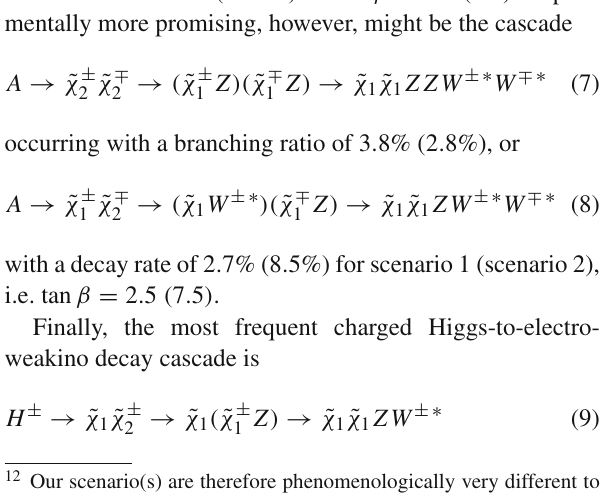
( ˜ χ) dominant production modes (for the LHC at 13TeV) and decay modes h , EFT to electroweakinos of the heavy Higgs bosons H , A and H + , for